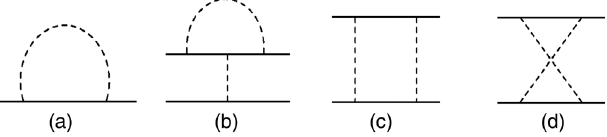
FIG. 5. One-loop diagrams contributing to the self-energy correction (a), and renormalization of disorder coupling (b) – (d). Notice that contributions from (c) ladder and (d) crossing diagram are ultraviolet divergent only in ϵ (Sec. III A) and ϵ (Sec. IV C) n d expansions, while they produce ultraviolet finite contribution in ϵ expansion (Sec. IV B). Here, solid (dashed) lines represent m fermionic (disorder) field. FIG. 6. (a) The RG flow diagram obtained from Eq. (11) and (b) the resulting phase diagram in the Δ − Δ 0 plane, for ϵ Here, Δ is the tuning parameter for WSM-insulator transition [see Eq. (6)], and Δ 0 is the strength of random charge impurities. The blue dot and red dot, respectively, represent a critical and a multicritical point. The metallicity sets in through the multi- critical